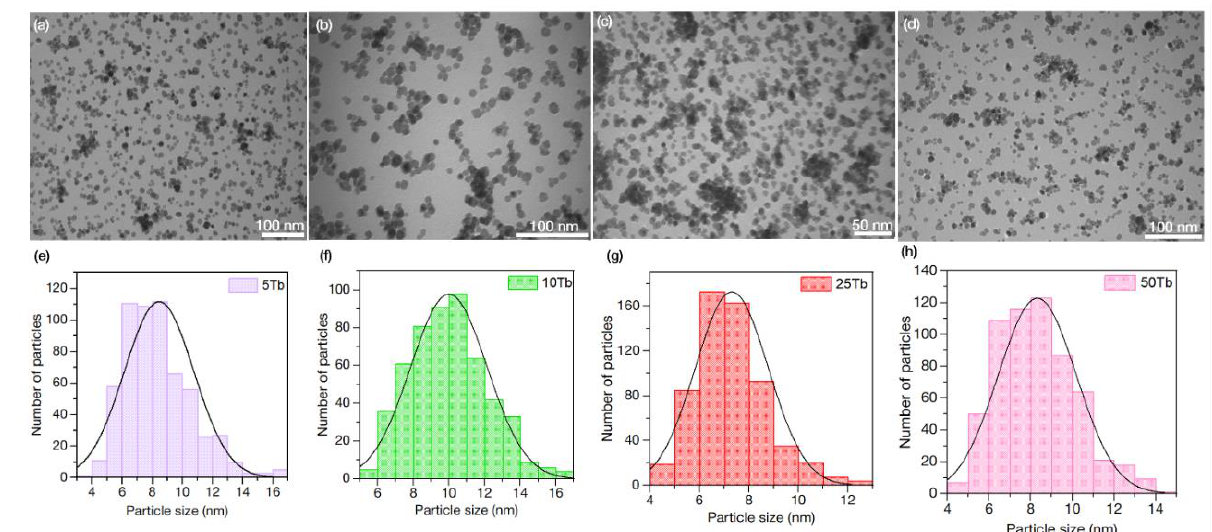
Figure 3. TEM images of ( a ) 5Tb MW, ( b ) 10Tb MW, ( c ) 25Tb MW, and ( d ) 50Tb MW; Particle size distribution of ( e ) 5Tb MW, ( f ) 10Tb MW, ( g ) 25Tb MW, and ( h ) 50Tb MW according to the TEM analysis.